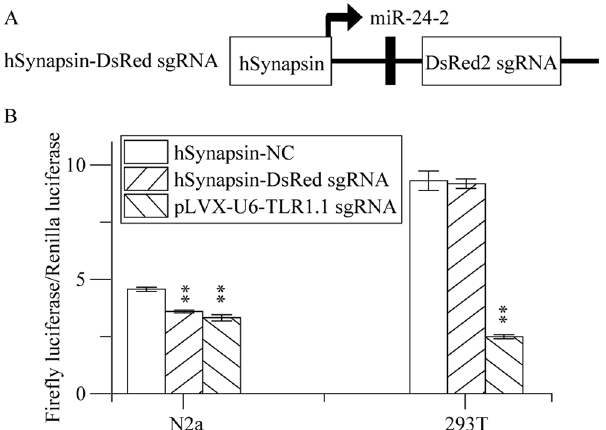
Figure 4. MiRNA based sgRNA cassettes serve as a useful tool for tissue specific genome editing. ( A ) Schematic overview of construction. ( B ) miRNA based sgRNA can be modified to adapt tissue specific genome editing. Briefly, DsRed2 sgRNA was inserted after miR-24-2 and driven by hSynapsin promoter, a neural specify promoter. DsRed2 sgRNA driven by hSynapsin was co-transfected with Cas9 expression vector, pGL3- control NHEJ V2 reporter vector, and pRL-TK into 293T kidney cells or N2a mouse neural cells. 6 days after transfection, luciferase assay was used to determine the nuclease activity of neuron specific sgRNA driven by hSynapsin. The expression of reporter gene was inhibited in N2a cells instead of 293T